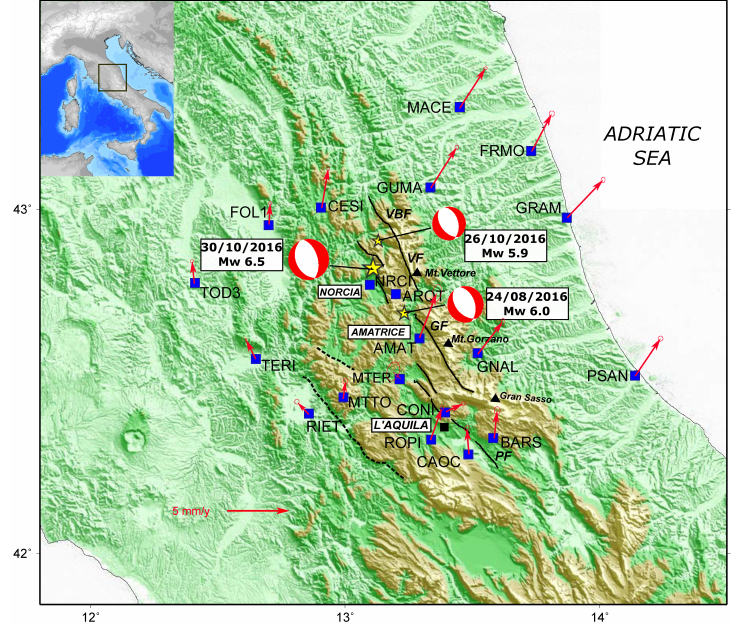
Figure 1. GPS sites (blue squares); GPS velocities in the Eurasian fixed reference frame from [12] (red arrows); main faults from [13] (black lines: VBF: Vettore-Bove Fault; VF: Vettore Fault; GF: Gorzano Fault; PF: Paganica Fault); focal mechanisms of the three events show the extensional style (red and white beach balls). Velocities with respect to the Eurasian fixed frame [14] and error ellipses at the one sigma confidence level are